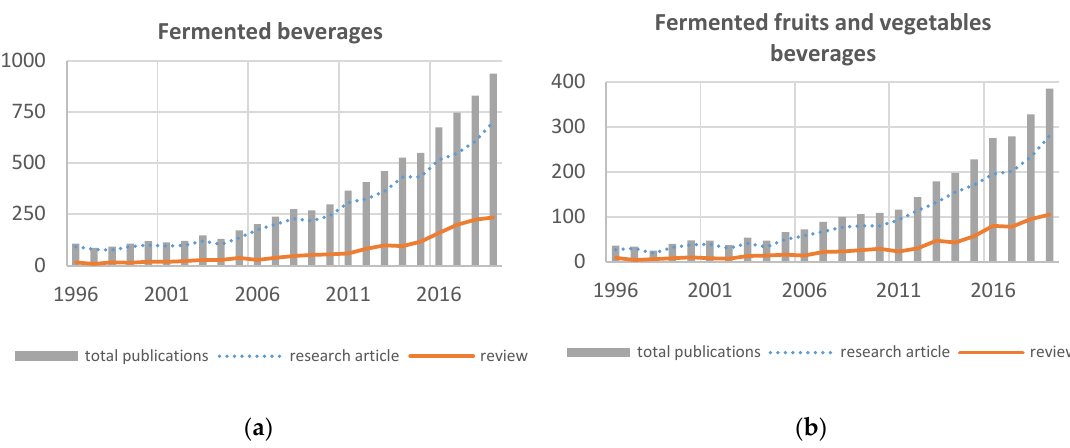
Figure 1. Publication trends per year on fermented beverages ( a ) and fruit and vegetable fermented beverages ( b ) according to the Science Direct database.